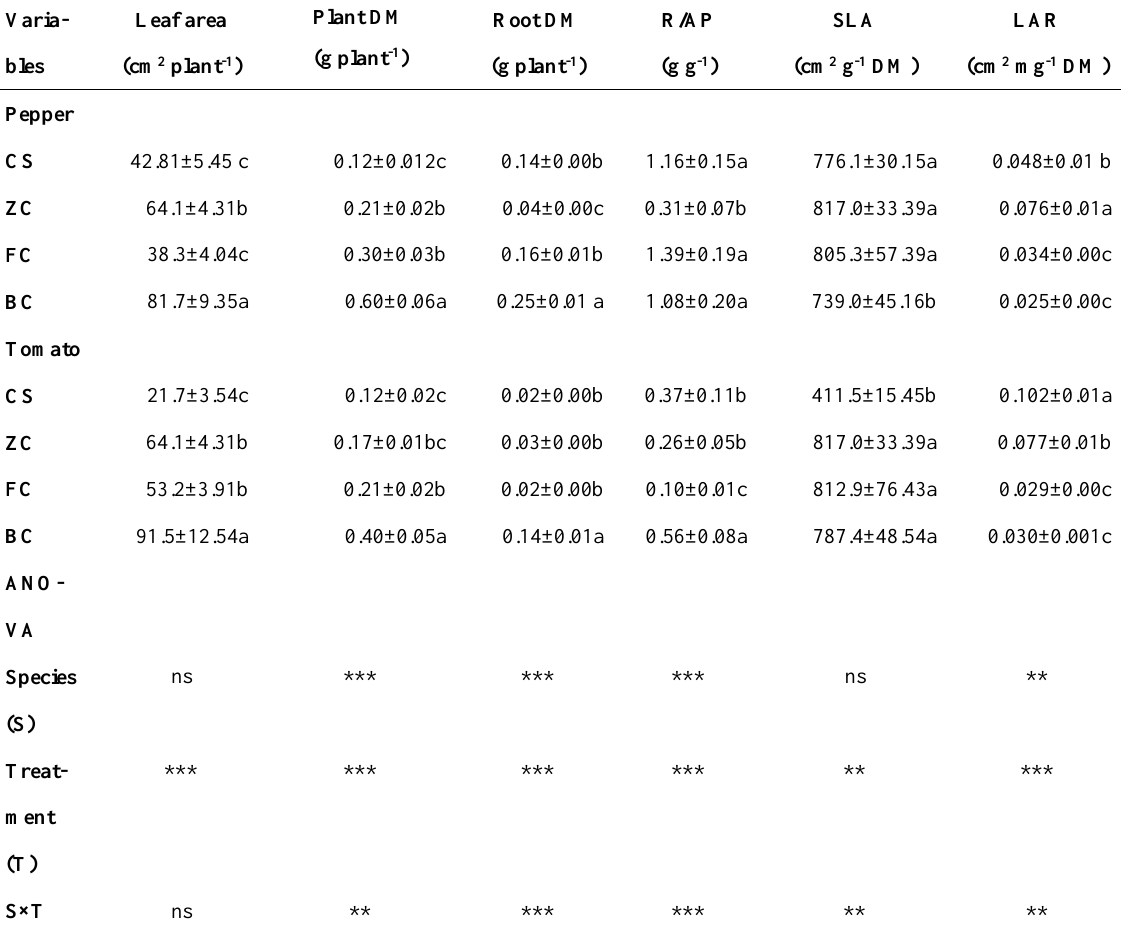
Carrot compost (ZC), fat compost (FC), biosolids compost (BC). A commercial substrate (CS) was used as a control treatment. Values represent means S.E (n=27). For each plant species, the data of all doses have been joined evaluating the effect of the compost as the main factor. Within columns and plant species, means followed by the same letter do not differ significantly (P≥0.05) according to Duncan’s test. Significance of the analysis of variance (ANOVA):